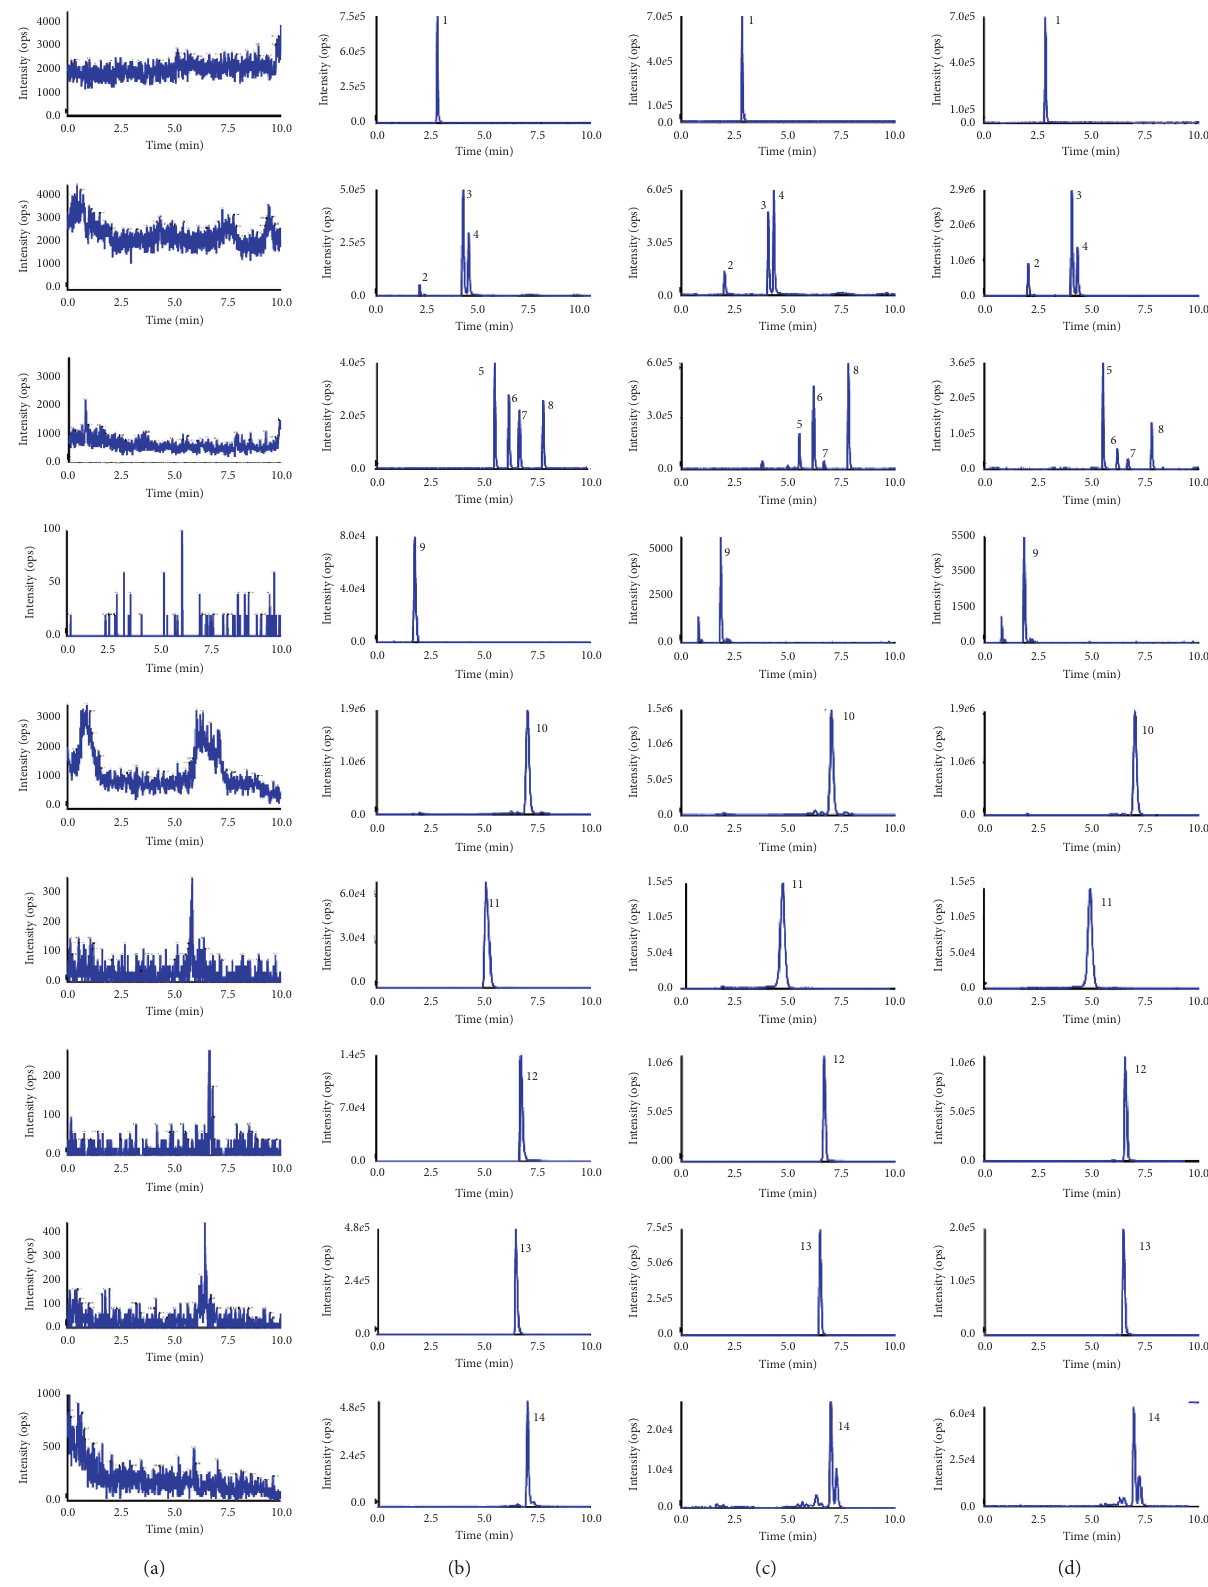
Figure 2: SIM chromatograms of 12 active ingredients and IS in rat tissue. (a) Blank tissue; (b) blank tissue spiked with standard solution and IS; (c) kidney tissue samples after intragastric administration of crude Qing’e pills; and (d) kidney tissue samples of oral administration of salt-processed Qing’e pills (1. Escoparone, 2. psoralenoside, 3. psoralen, 4. Isopsoralen, 5. isobavachin, 6. bavachin, 7. bavachalcone, 8. isobavachalcone, 9. pinoresinol diglucoside, 10. rhein, 11. geniposidic acid, 12. psoralidin, 13. neobavaisoflavone, and 14.